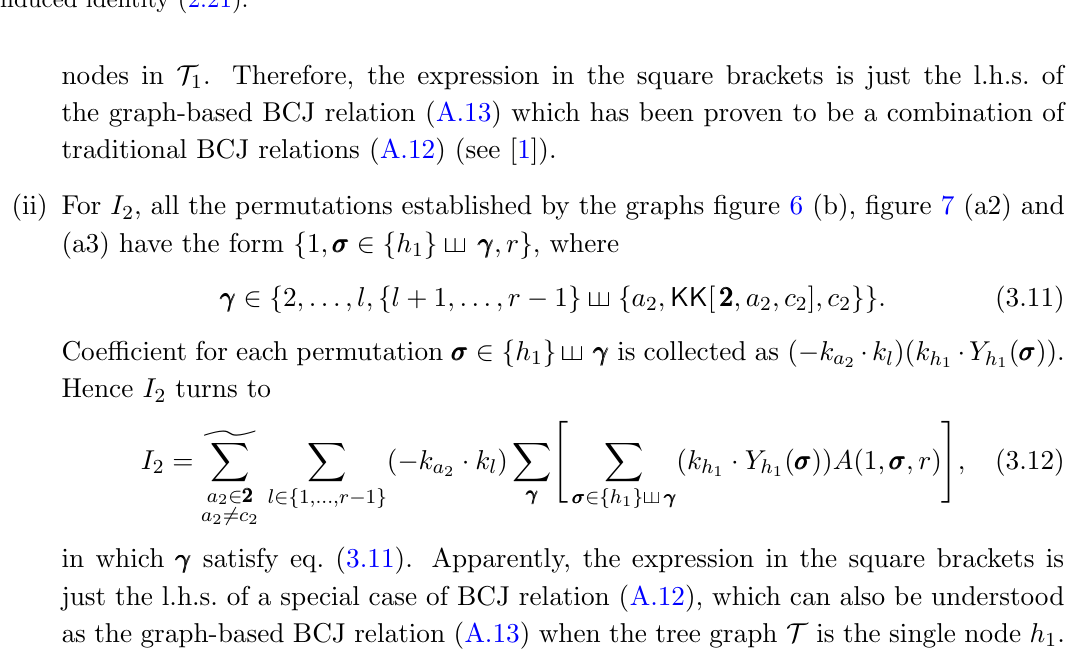
and the gluon d is the removed gluon b 0 in the j 222 j j 222 j